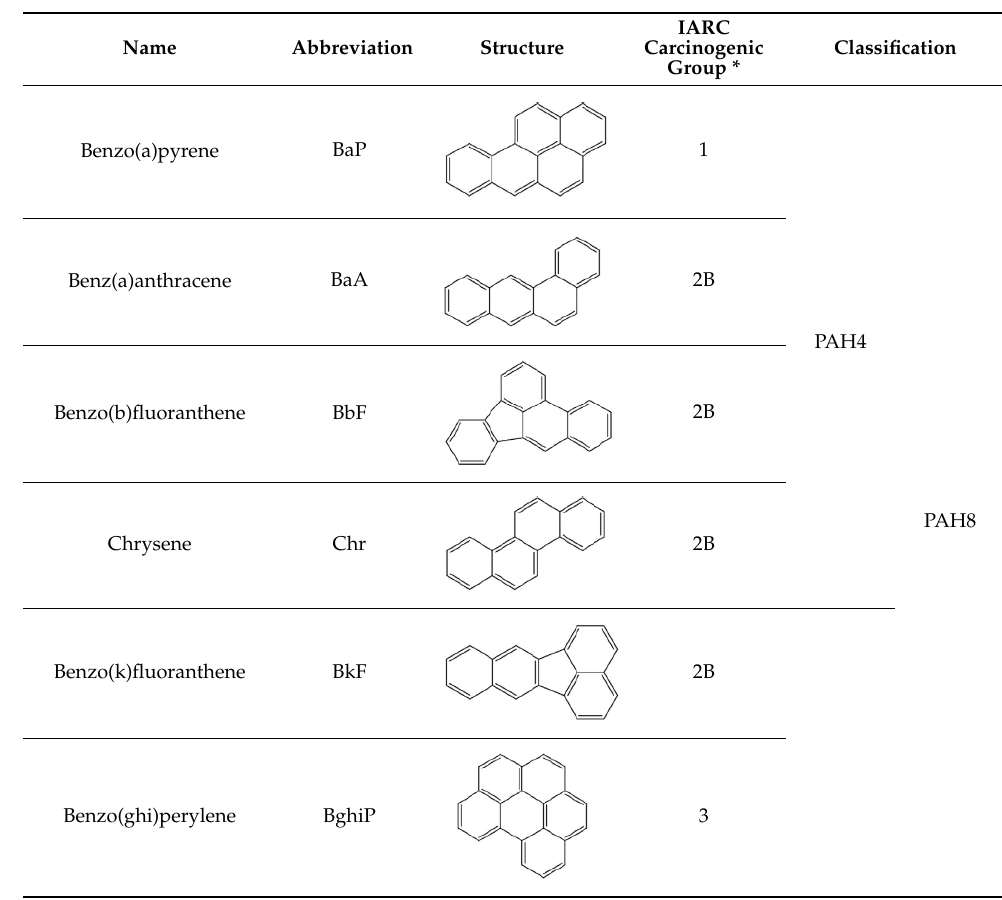
Table 1. Compounds of polycyclic aromatic hydrocarbons selected by EFSA as markers for the occurrence of PAHs in food [26].